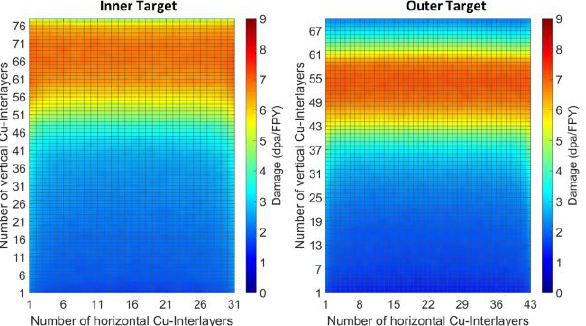
Figure 20. Nuclear damage (dpa/FPY) distribution on Cu/CuCrZr components of the inner ( left ) and outer ( right ) target, with HCPB blanket.